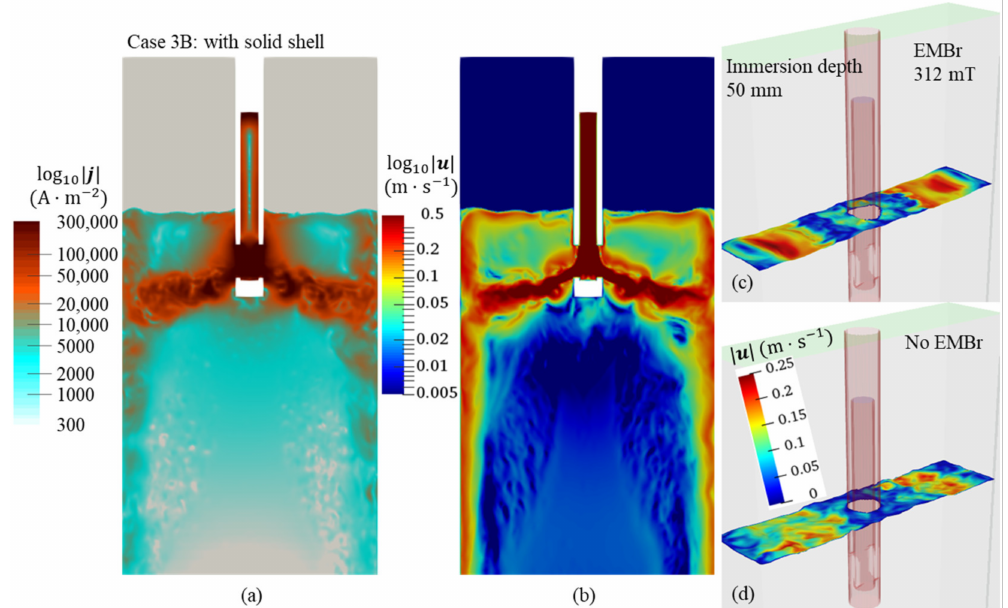
Figure 12. Meniscus flow for Case 3B: ( a ) induced e-current density and ( b ) melt velocity (midplane); ( c ) interface velocity with EMBr compared with ( d ) Case 0B without